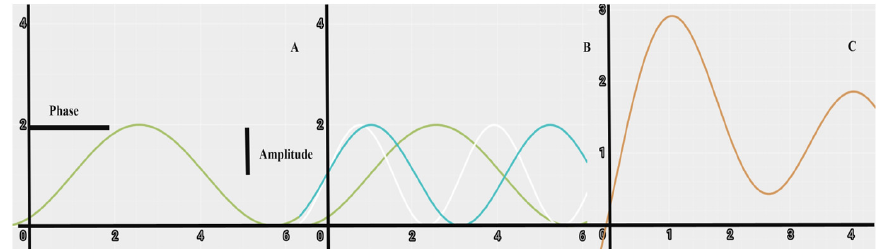
Figure 3. ( A ) simple cosine curve, ( B ) curves for harmonic terms, ( C ) curve produced from addition of curves in ( B ).